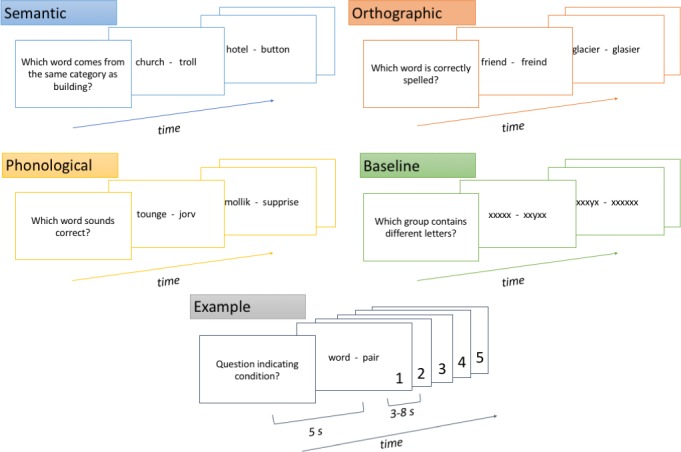
Schematic overview of the word pair task used during the fMRI session.The different blocks for each language choice condition are shown, the example block shows the timing in seconds for the blocks, and the sequence of 5 word pairs after each question.